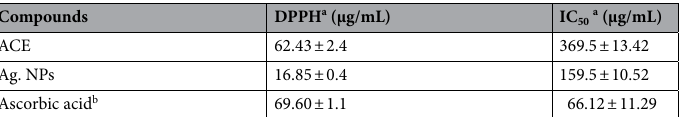
Table 2. Antibacterial activity of the ACE and Ag. NPs of P. lanceolata LD 50 and IC 50 is concentration causing 50% inhibition. a IC 50 = Signifies the means (± standard error) of 3 equivalent amounts (p < 0.05). b